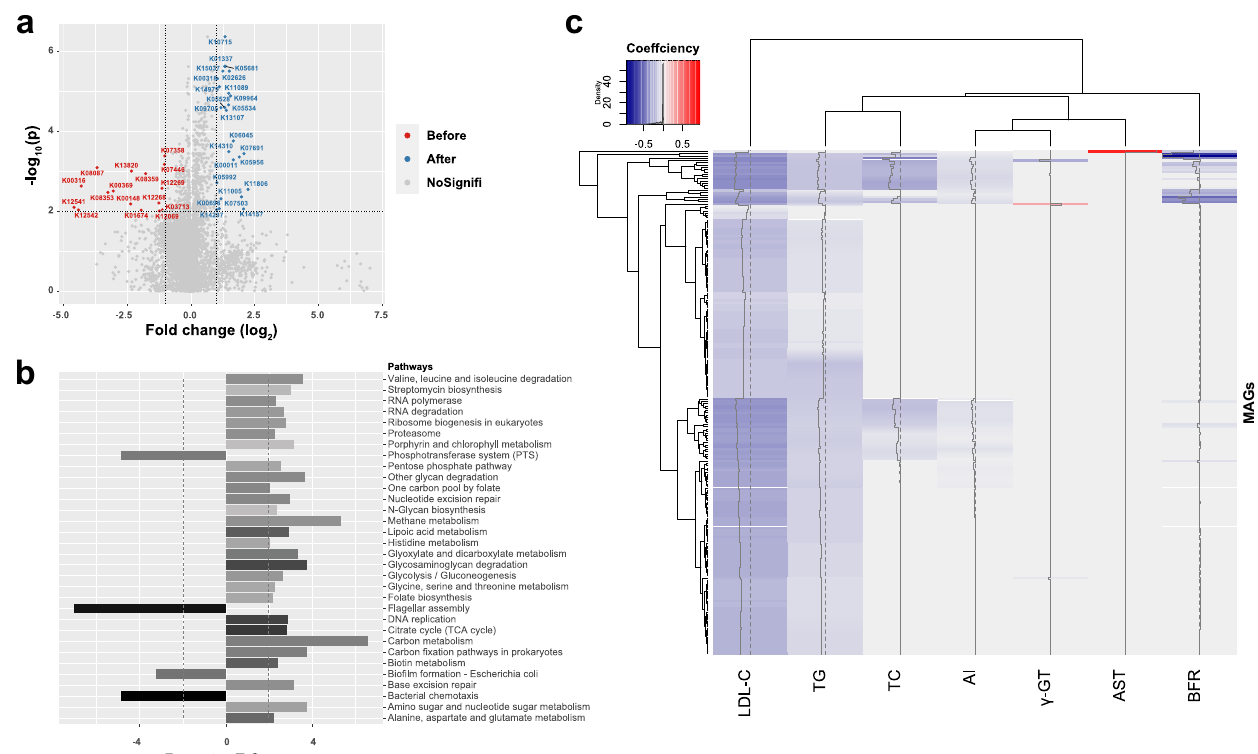
Fig. 4 IF intervention changes the functional potential of the gut microbiota. a In the volcano plot, each dot represents a KEGG Orthologues (KO) and is distinguished by color. KOs enriched before the experiment are shown in red, and KOs enriched after the intervention are shown in blue. b The X axis represents the reporter Z score, and the y axis represents the functional pathways. The pathways with Z-scores less than zero were enriched before intervention, and those with values above zero were enriched after the intervention. The darkness of the bars indicates the completeness of each pathway. c Heatmap of associations between the relative abundances of KOs and clinical parameters. Red represents positive correlation, whereas blue represents negative correlation. AI atherosclerosis index, AST aspartate aminotransferase; BFR body fat ratio, DBP diastolic blood pressure, γ -GT gamma-glutamyl transferase, LDL-C low-density lipoprotein cholesterol, TC total cholesterol, TG